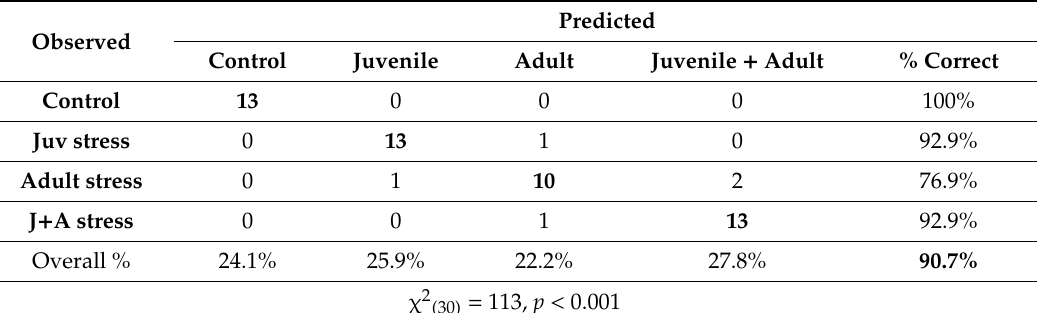
Table 1. Results of the multinomial logistic regression for group classification.